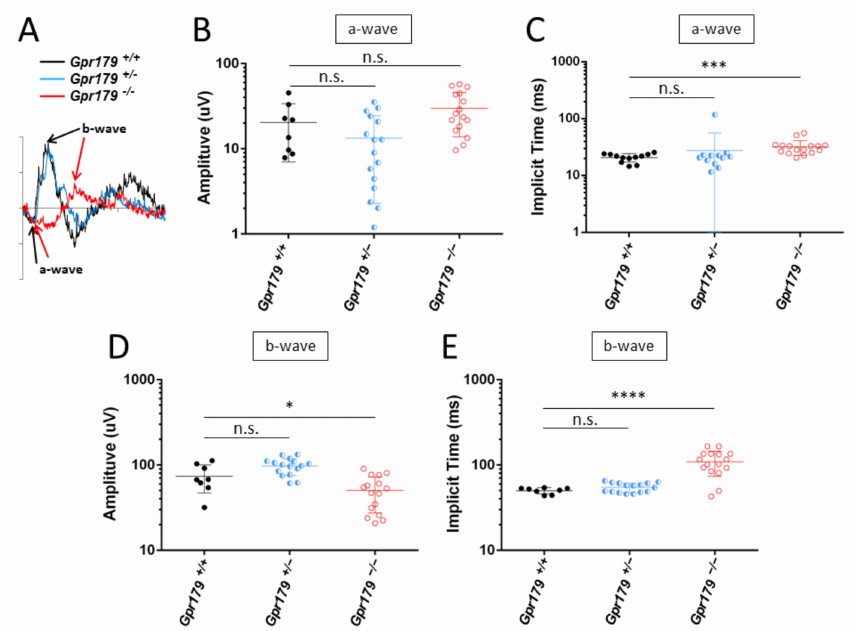
Figure 4. Photopic electroretinogram (ERG) responses. Light-adapted ERG recordings with a stimulus intensity of 3 cd.s/m 2 were obtained from 10 Gpr179 +/+ (black line), 12 Gpr179 +/ − (blue line), and 10 Gpr179 − / − (red line) littermates. ( A ) Representative waveforms. The scale marks indicate 100 ms (time in abscissa) and 50 µ V (amplitude in ordinate). a-waves and b-waves are depicted with black arrows for the Gpr179 +/+ mouse recording, and red arrows for the Gpr179 − / − mouse recording. Amplitude ( B ) and implicit time ( C ) of the a-wave. Amplitude ( D ) and implicit time ( E ) of the b-wave. Abbreviations: n.s. = non-significant, *: p < 0.05, ***: p < 0.001, ****: p < 0.0001.